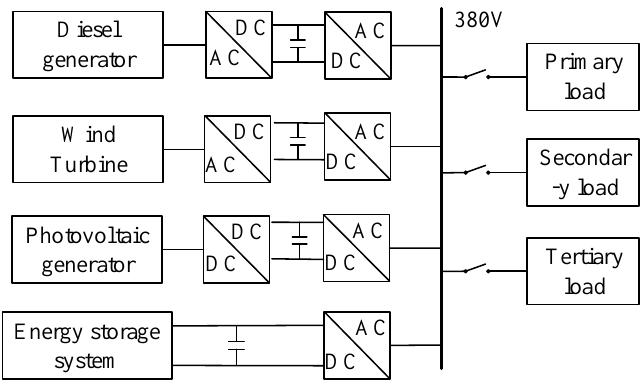
Figure 1. The topology of islanded microgrid.